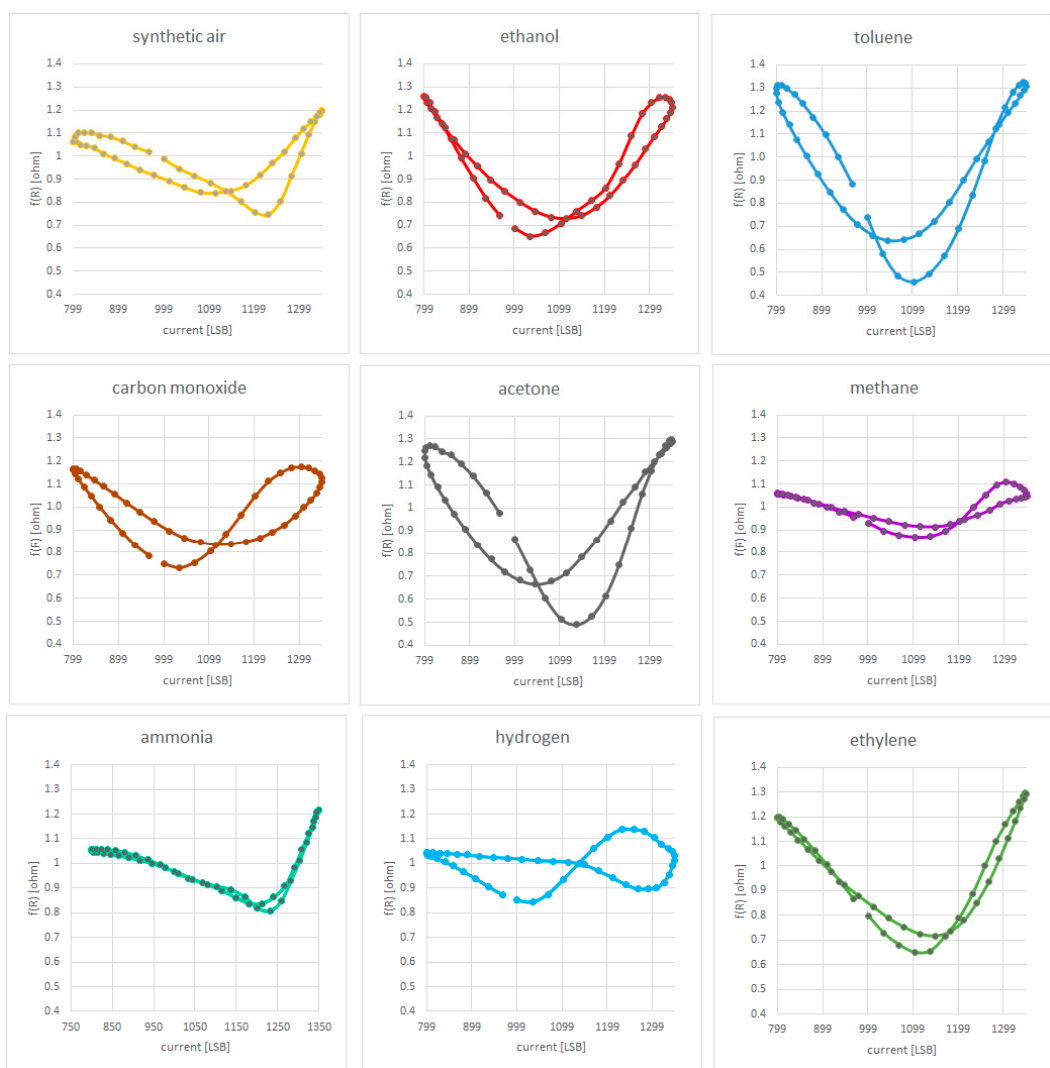
Figure 26. Gas fingerprint used for AI gas identification.